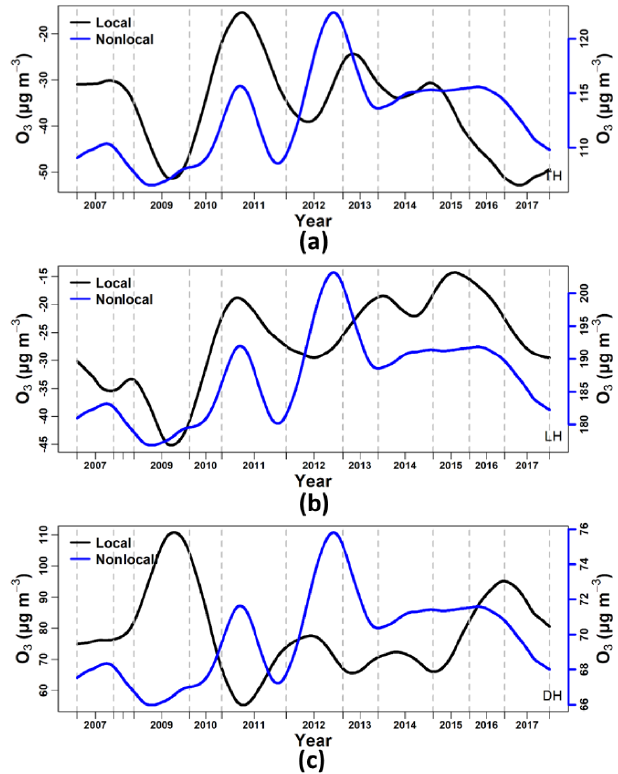
Figure 9. Long-term trend of ozone contributed by local (black) and nonlocal (blue) emission sources from 2007 to 2017 at (a) TH, (b) LH, and (c) DH stations during ozone